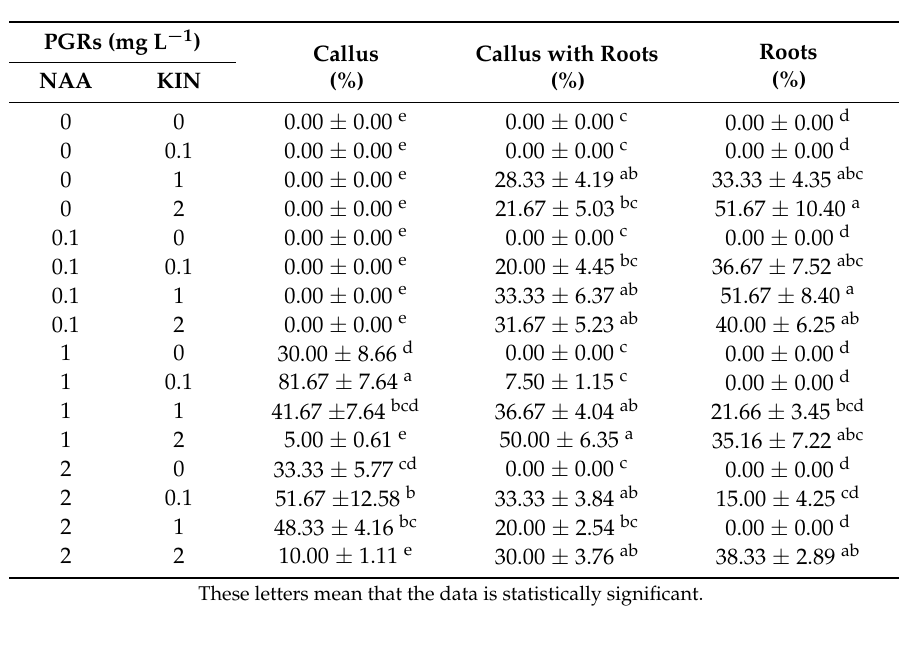
Table 1. Morphogenetic responses of plant growth regulators (PGRs) on A. pichinchensis leaf explant at 20 days culture.